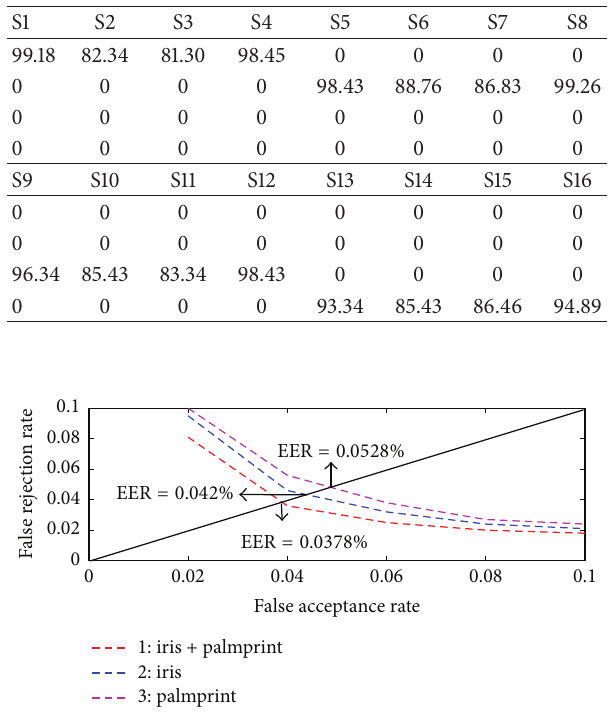
Table 4: Matching scores using 𝐾 -nearest neighbor algorithm.